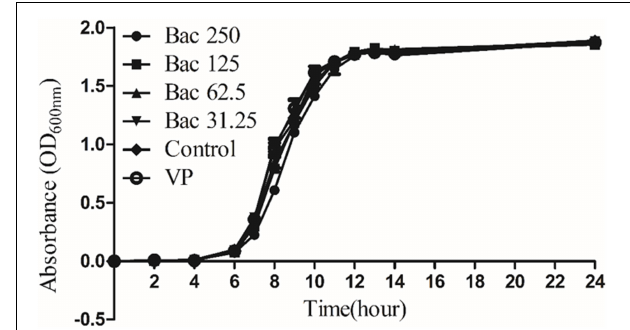
FIGURE 2 | Growth kinetics of Staphylococcus saprophyticus strains in BHI under sub-inhibitory concentrations of baicalin or verapamil. OD 600 nm values are the means ± SD from three independent experiments. Sub-inhibitory concentrations of baicalin are 250, 125, 62.5, and 31.25 mg/L, and verapamil had no effect on bacterial